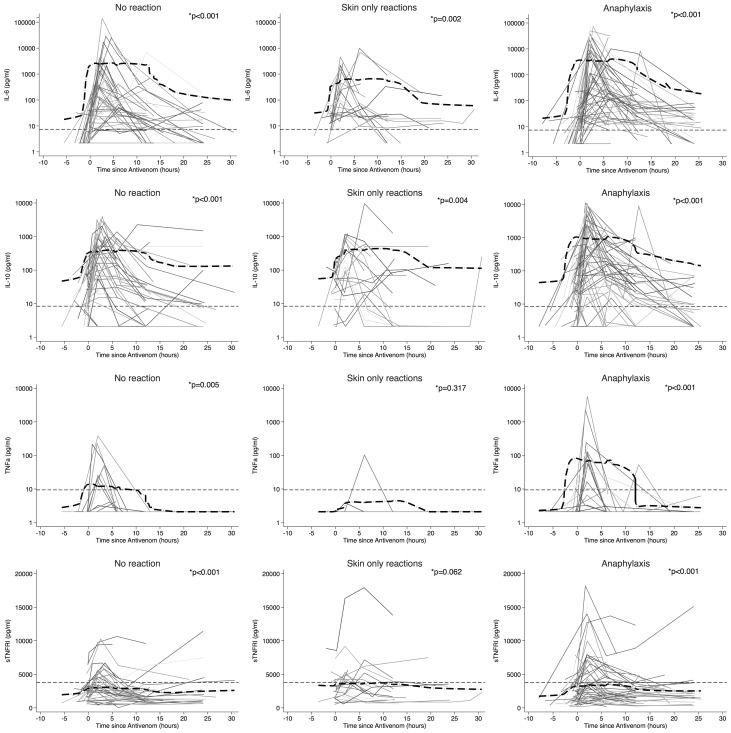
Changes in IL-6, IL-10, TNFα and sTNFRI concentrations during treatment with antivenom.Lowess curve (thick dash-dot line). Upper limit (99th centile healthy control values from our laboratory) (thin dashed line). * p-value for difference between pre-antivenom concentration and peak concentration during the first four hours post-antivenom (Wilcoxon Signed Rank Test).